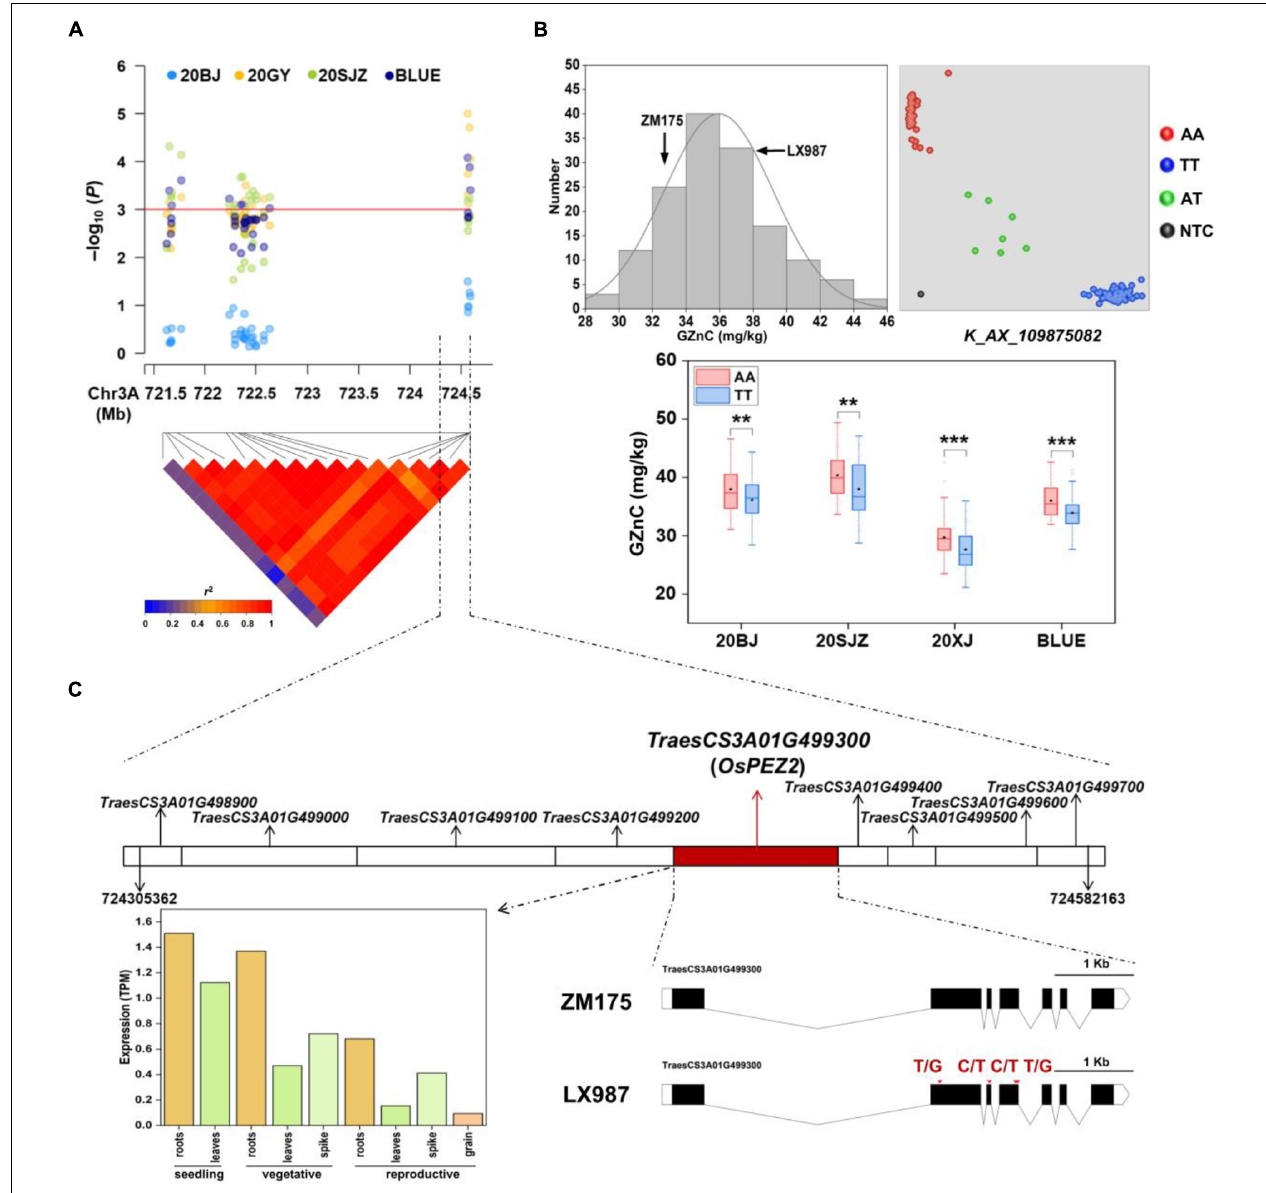
FIGURE 2 | (A) Local Manhattan plot and linkage disequilibrium (LD) heatmap of single nucleotide polymorphisms (SNPs) within the 3AL quantitative trait loci (QTL) identified for grain zinc concentration (GZnC). 20BJ, 20GY, and 20SJZ: Beijing, Gaoyi, and Shijiazhuang locations, respectively, 2019–2020. BLUE: best linear unbiased estimations. (B) The validation of 3AL QTL in ZM175/LX987 RIL population. Histograms for GZnC in the population using BLUE values across three environments (top and left); genotype calling result of the kompetitive allele-specific PCR (KASP) markers for K_AX_109875082 in the population (top and right); allelic effects of K_AX_109875082 on GZnC in the population across 20BJ, 20SJZ, 20XJ, and BLUE (bottom). AA and TT indicate two homozygous genotypes for this marker from LX987 and ZM175, respectively. AT indicates the heterozygous genotype, and NTC represents no template control. 20XJ: Xinjiang location in during 2019–2020. The black diamond in each box indicates the mean. * p < 0.05; ** p < 0.01; *** p < 0.001; ns: not significant. (C) The nine annotated genes identified close to AX_109875082 with the highest p in the 3AL QTL region (top); the spatio-temporal expression profiles of the candidate gene TraesCS3A01G499300 (bottom and left); the gene structure of TraesCS3A01G499300 containing four exons with missense variants between ZM175 and LX987 (bottom and right), and red arrows indicate the positions of the exon missense variants between ZM175 and